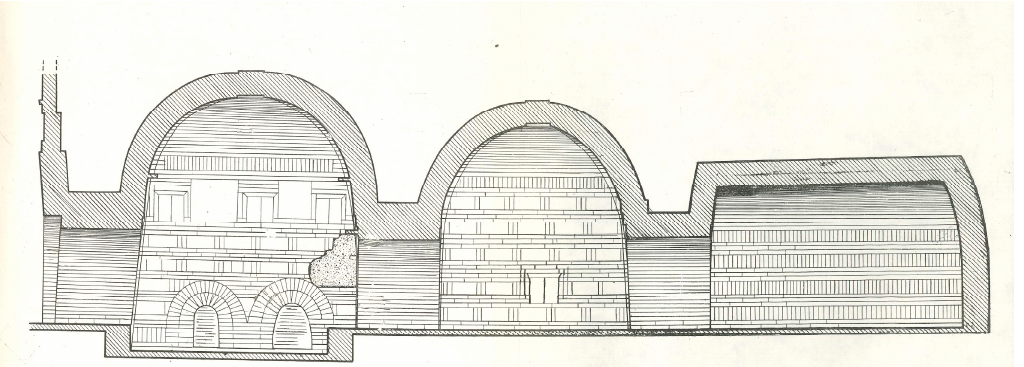
Figure 2. Cross section, Xincheng M3, brick, Wei-Jin period (220–317). (Gansusheng Bowuguan et al. 1985, Figure 13).